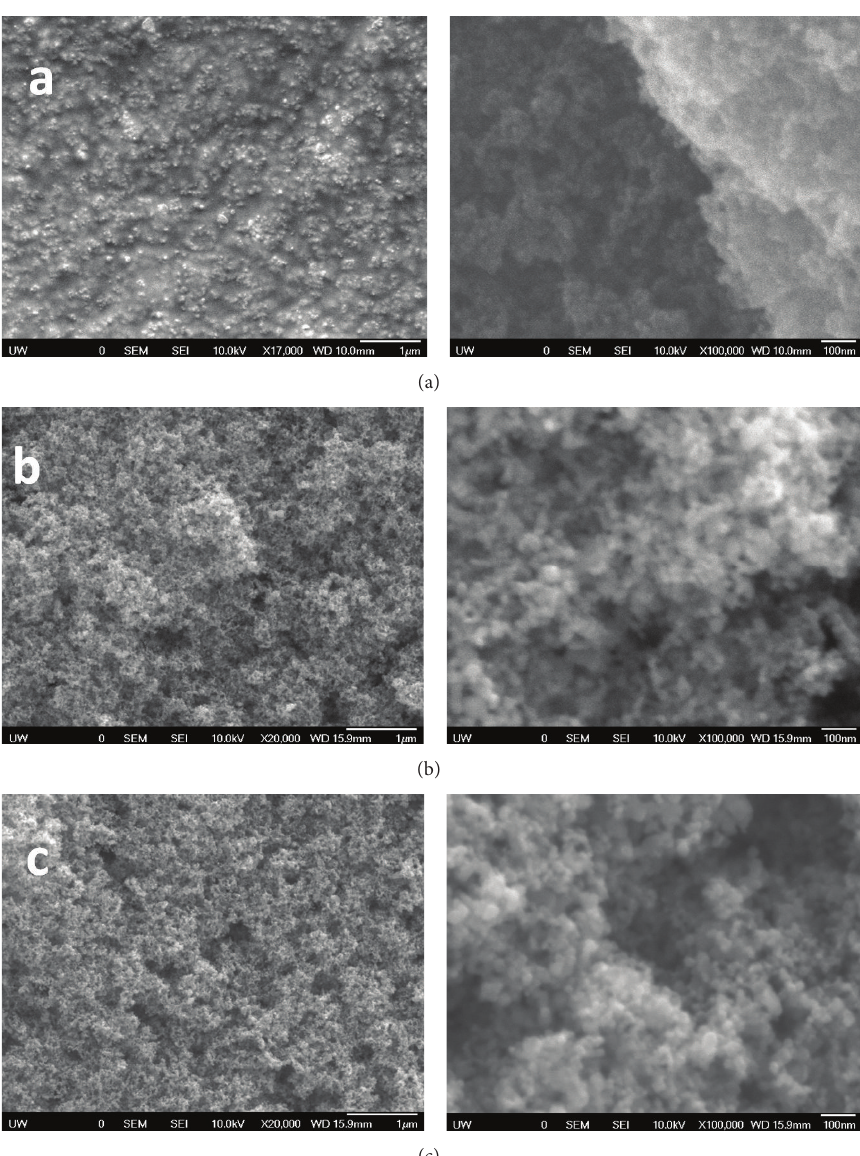
F 6: SE� images of porous ��TS modi�ed TiO